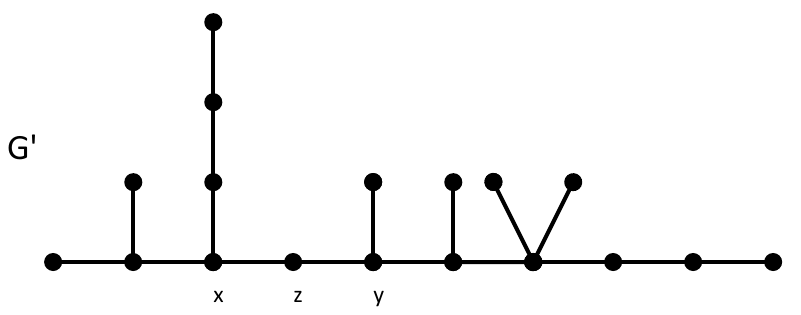
Figure 11: Fusing two pendant vertices 𝑥 ′ and 𝑦 ′ to obtain a tree 𝐺 ′ in which the vertices 𝑥 ′ and 𝑦 ′ become a single vertex 𝑧 in 𝐺 ′ and where p (3 , 6 , 11 , 15 , 17 , 19 , 15 , 15 , 5 , 3).